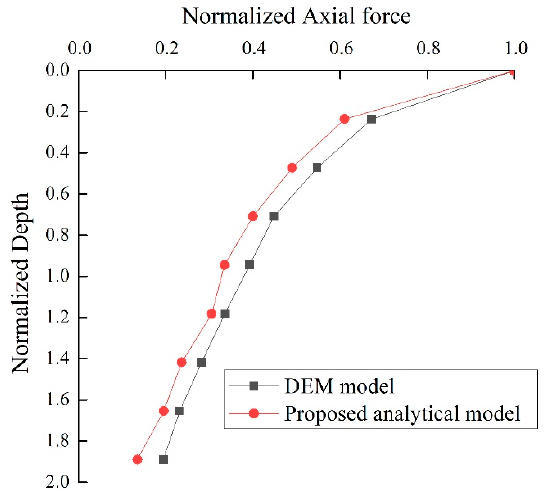
Figure 17. The axial force-depth from the analytical method and DEM model.